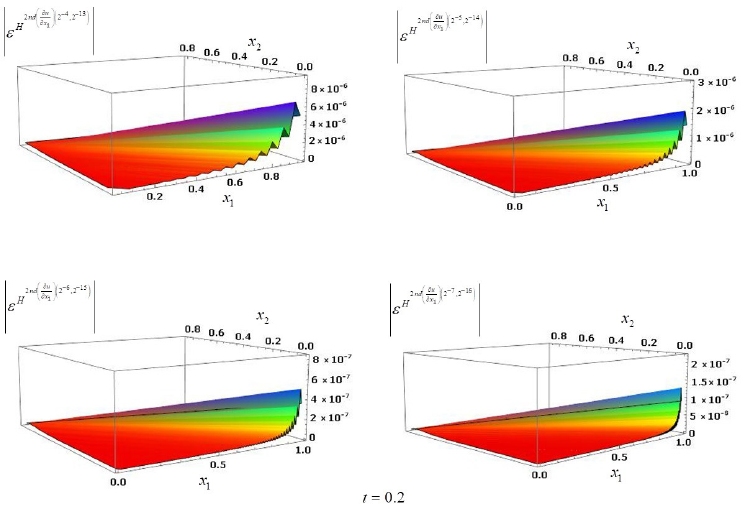
(cid:16) (cid:17) ∂ u . ∂ x 1